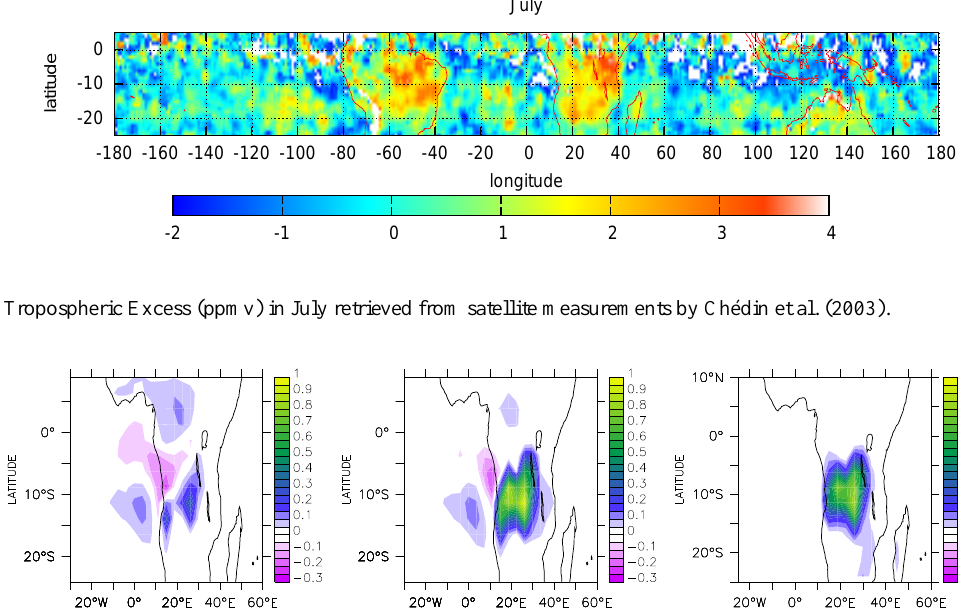
Fig. 12. Weighting function of CO2 column satellite as determined by Ch´edin et al. (2003).